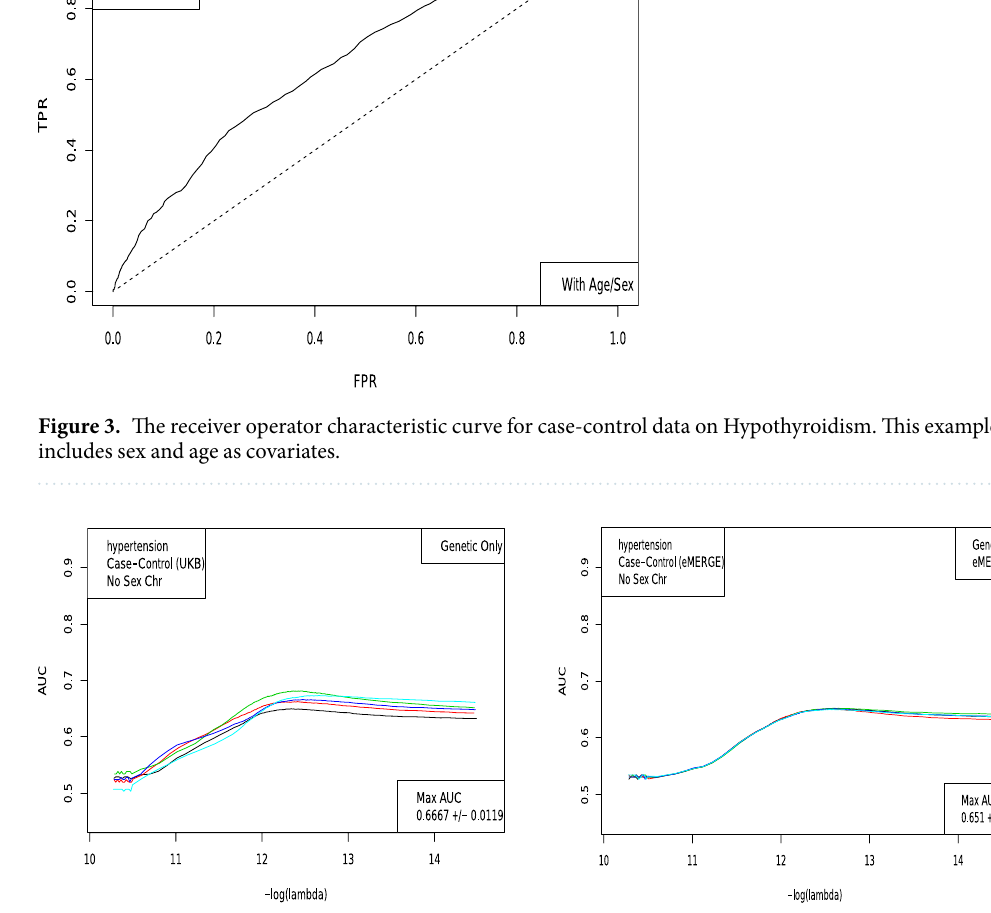
Figure 4. AUC computed on 5 holdback sets (1,000 each of cases and controls) for Hypertension, as a function of λ . A. UK Biobank and B.